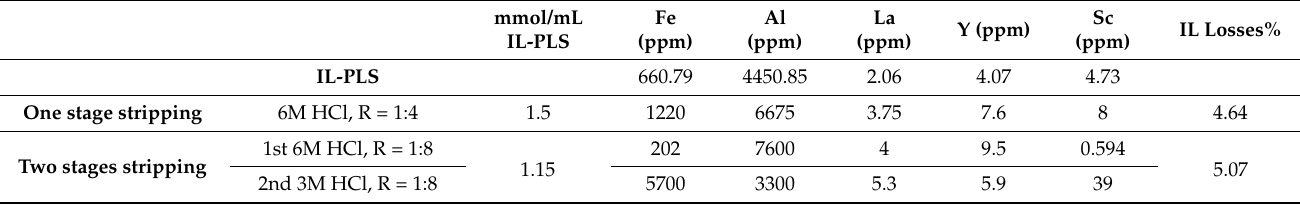
Table 2. Comparison of the different concentration in metals in the different streams from the proposed stripping